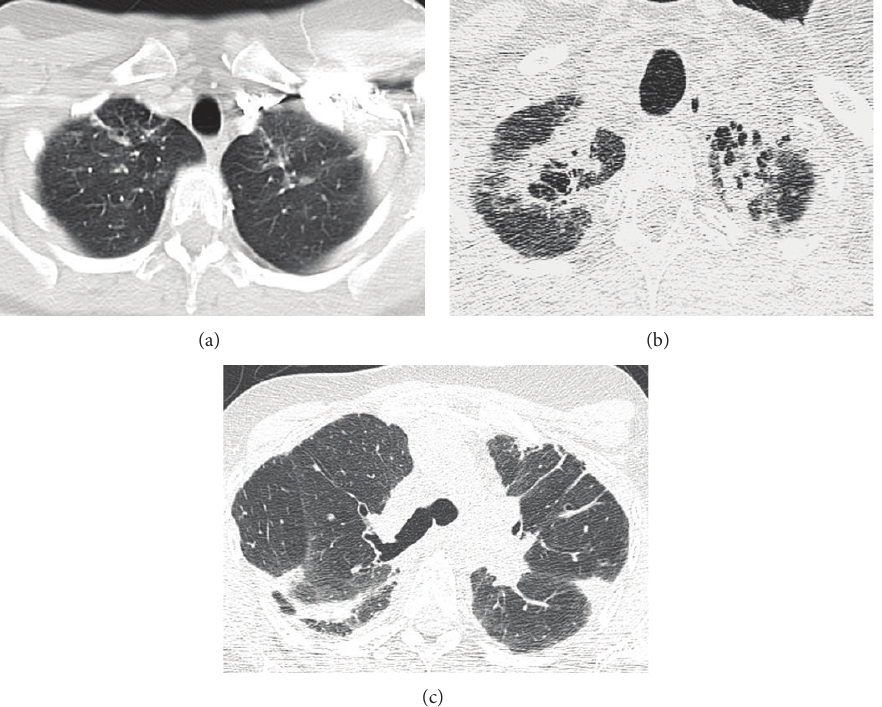
Figure 7: Case 2. (a) Axial HRCT scan shows very discrete lineal opacities in both lung apices. (b) Axial HRCT scan at the same level compared to (a) two years and two months later shows a loss of volume and prominent parenchymal fibrotic infiltrates. (c) Axial HRCT image at the level of carina reveals lung architectural distortion, as well as the presence of pleural thickening and subpleural parenchymal